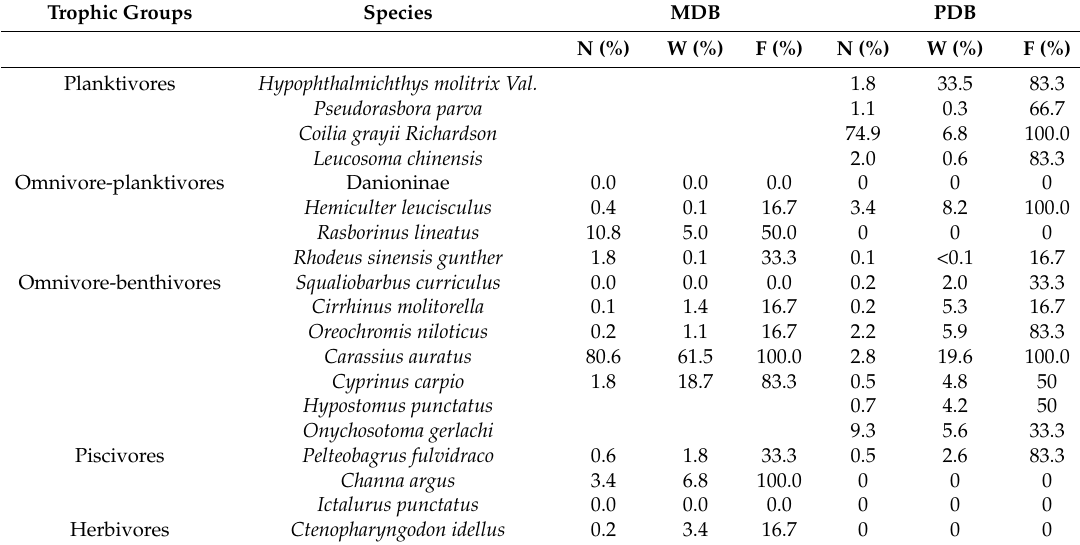
Table A1. Fish community composition in MDB and PDB during April 2010–March 2011. W (%) and N (%) are annual mean percentage weight (g) and number of each species of the total catch, F (%) is the percentage frequency of occurrence of each species in all samplings (i.e., whether the species was present or not).